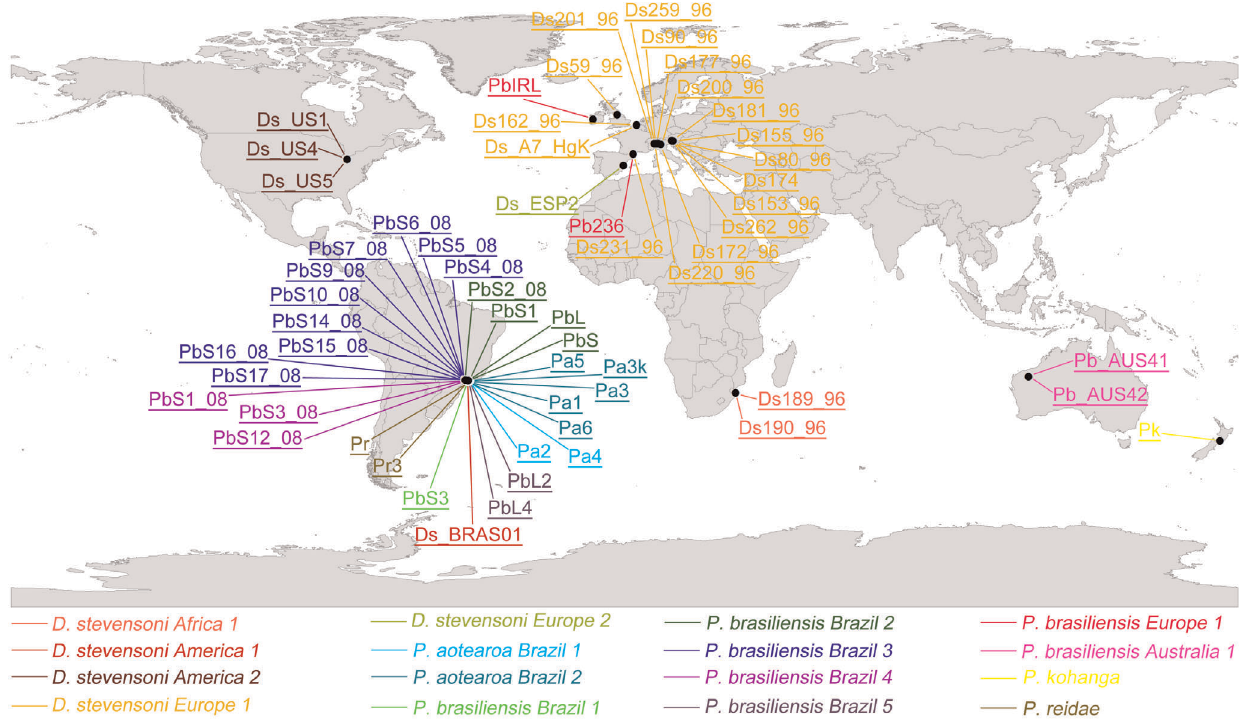
Figure 3. Global distribution of the EG species, determined by COI sequence data. Letters and numbers in the map refer to the analyzed specimens (see Table S1 for more details). Different EG species are indicated by different color codes.